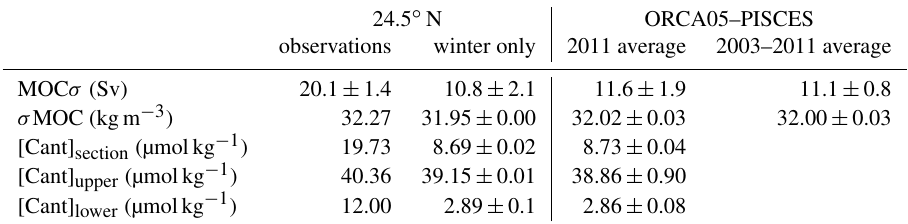
Figure 5. Volume transport (Sv) integrated zonally at 24.5 ◦ N. In panel (a) , the volume transport was computed in three water mass classes over the period January–March 2011. The three classes encompass (1) North Atlantic Central Water (NACW), Antarctic Intermediate Water (AAIW) and Mediterranean Water (MW) flowing in the upper MOC (red) and (2) North Atlantic Deep Water and (3) Antarctic Bottom Water (AABW) flowing in the lower MOC (blue). Model results (filled bar plot) are compared with the observation-based estimates from Hernández-Guerra et al. (2014) (hatched bar plot). In panel (b) , the volume transport was computed in density level ( σ 1 with 0.1kgm − 3 resolution) from model output over the year 2011. Black horizontal lines indicate the density where the MOC magnitude was found in the model over the study period ( σ 1 = 32 . 05 from July to September and σ 1 = 31 . 95 for other months). They also represent the separation between the MOC limbs (upper in red, lower in blue). Table 3. Model–data comparison along 25 ◦ N. Average and standard deviation (SD) for observation-based estimates (column 2) and model output (columns 3 to 5). Model output: (1) January to March 2011 average, with SD being a measure of winter variability, (2) 2011 average, with SD corresponding to the 2011 seasonal variability, and (3) 2003–2011 average, with SD being the interannual